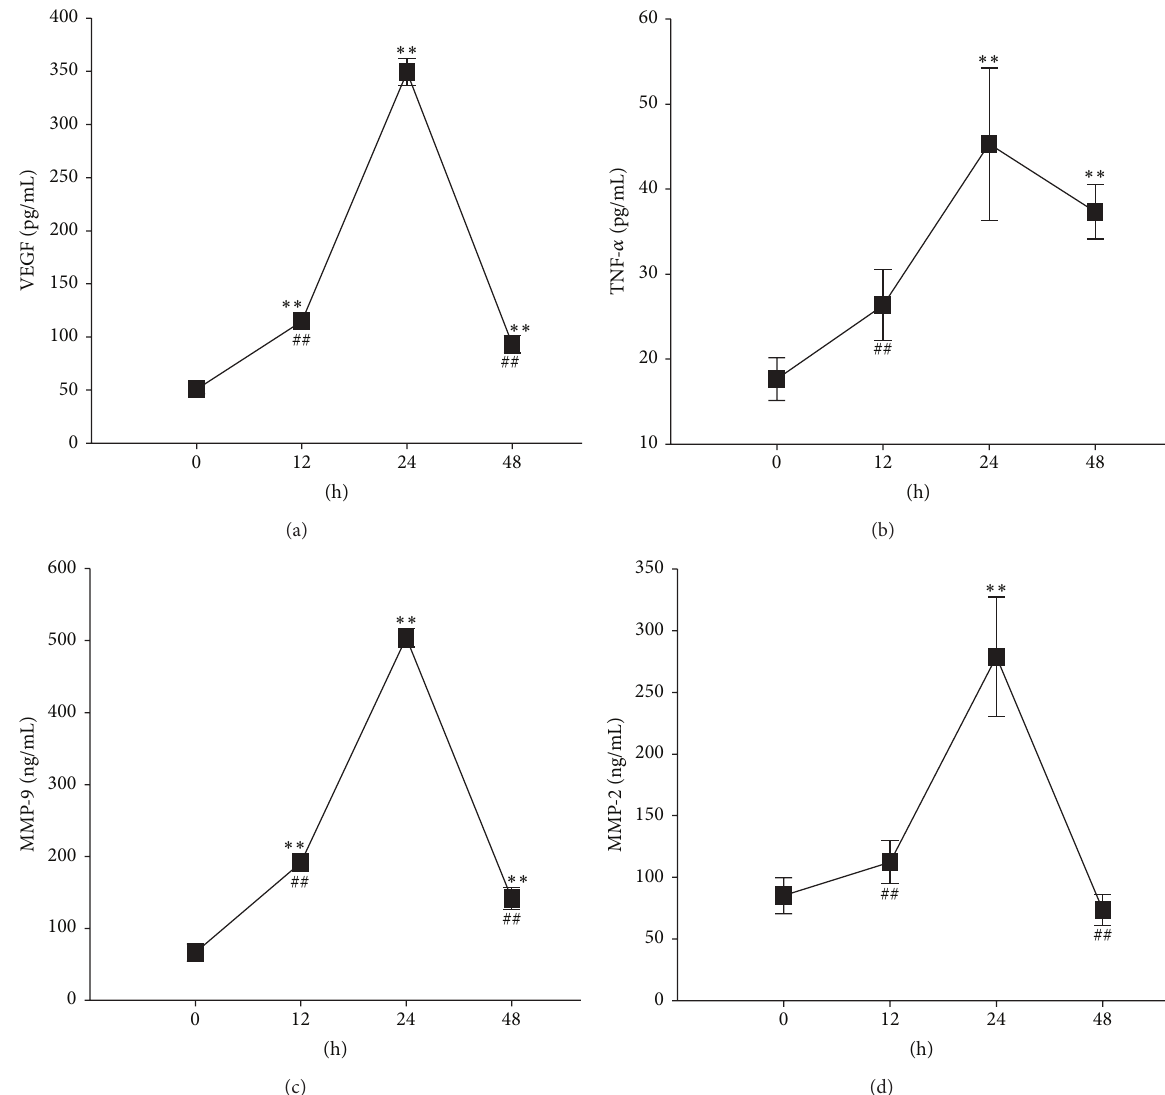
Figure 5: Protein levels of the four migration related factors whose mRNA level was also upregulated. The protein levels of those factors that were upregulated in mRNA level under hypoxia were also increased and peaked at 24 h as shown in (a) (VEGF), (b) (TNF- 𝛼 ), (c) (MMP- 9), and (d) (MMP-2). Results are shown as the mean ± SD values. Experiments were repeated three times. ∗ indicates 𝑃 < 0.05 indicates compared to the 0 h group. ∗∗ indicates 𝑃 < 0.05 indicates compared to the 0h group. # indicates 𝑃 < 0.05 compared to the 24h group. ## indicates 𝑃 < 0.01 compared to the 24 h